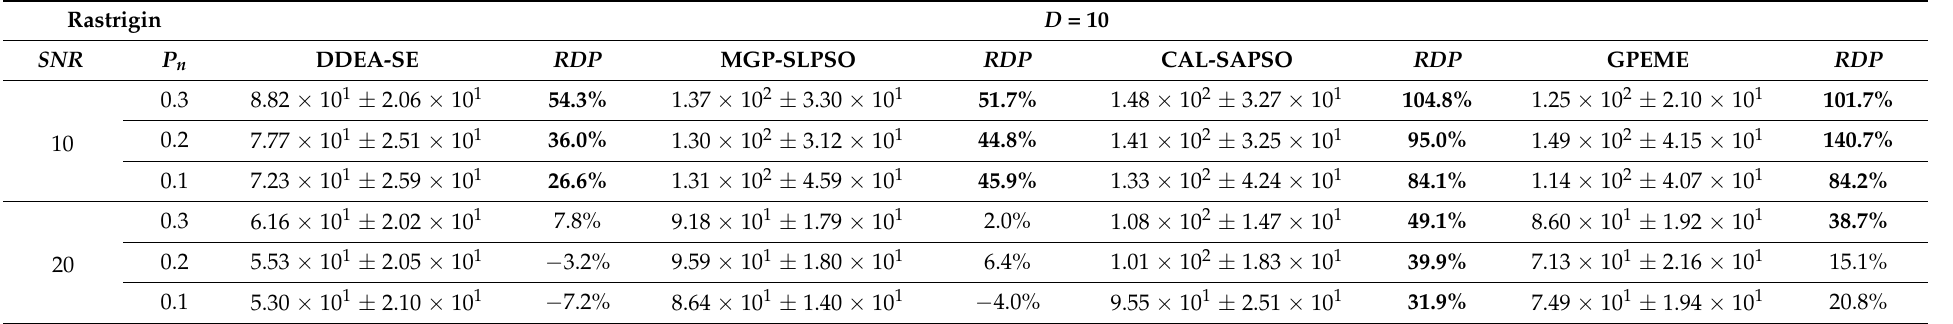
Table A9. Experimental results (with standard deviation) and RDP of DDEAs on 10-dimensional Rastrigin